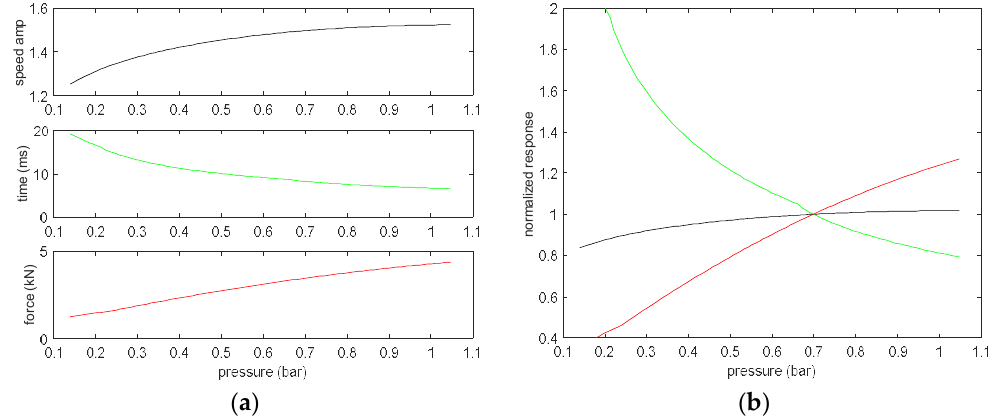
Figure 4. The effect of ball pressure on the: speed amplification (final velocity of ball divided by initial foot velocity (black); time the foot is in contact with the ball (green); and maximum impact force of the foot and ball (red), for ( a ) engineering units and ( b ) normalized to response at 0.69 bar